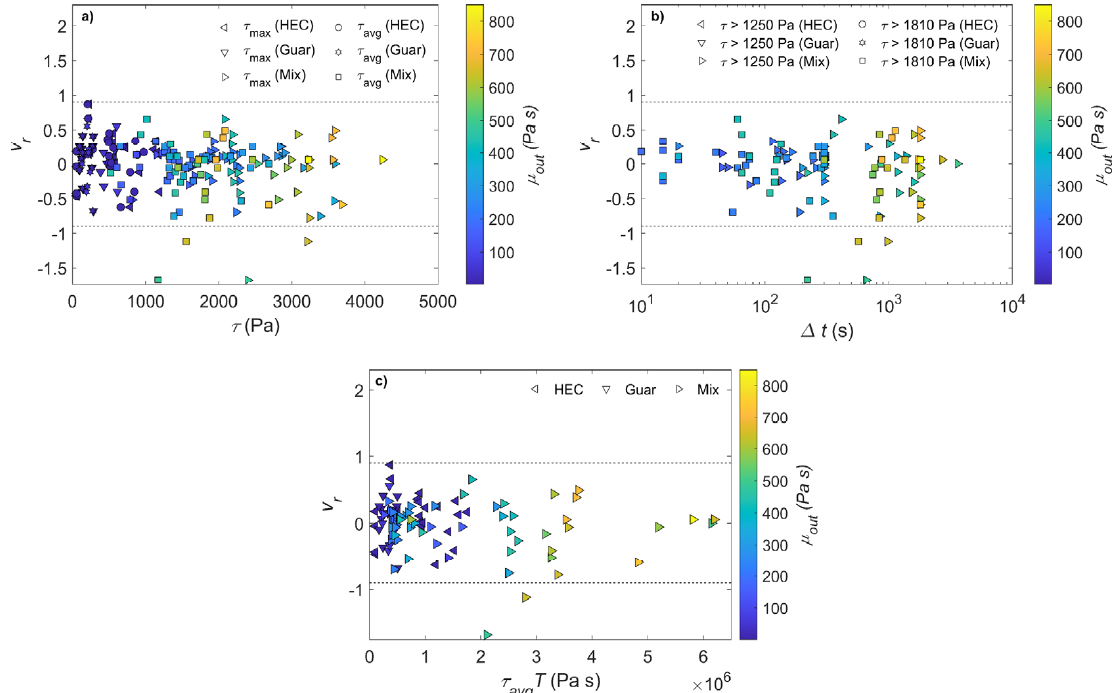
Figure 3. Bacterial removal efficiency as a function of ( a ) the maximum and time-averaged shear stress; ( b ) the time during which the shear stress exceeded the critical values reported in Lange et al. [27] for cell damage and lysis; ( c ) the product of average shear stress and treatment time. The horizontal dashed lines represent the 95% confidence interval for the removal efficiency calculated from the confidence intervals for the Colilert Quanti-Tray 2000 assay. The color bars report the viscosity of the substrates.